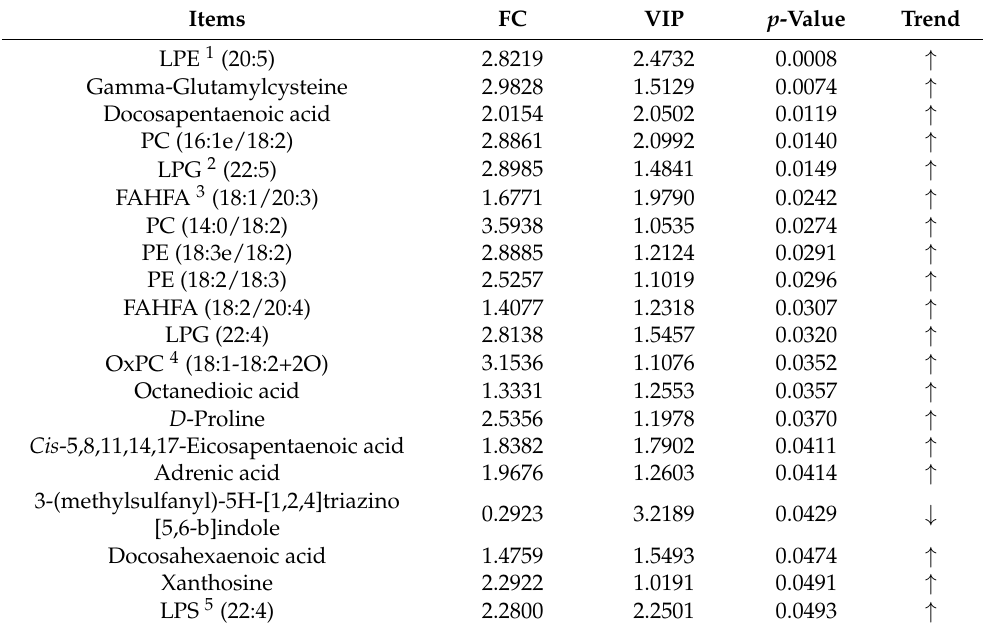
Table 10. Differential metabolites in negative ion